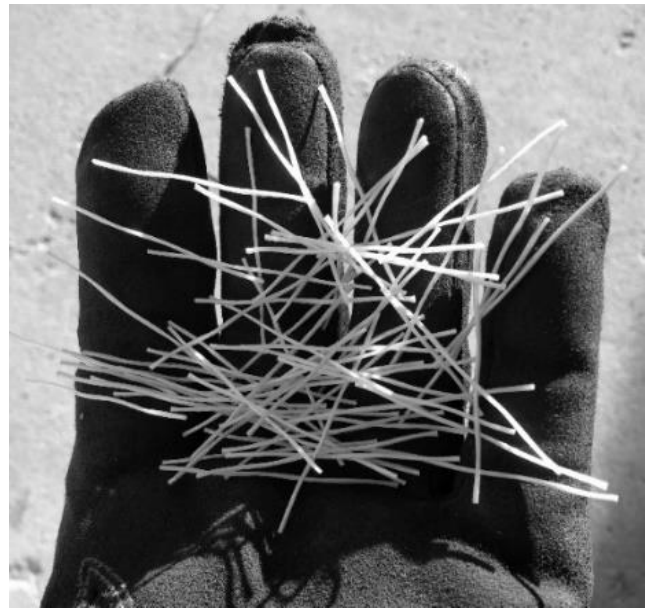
Figure 1. Macrofibers used in this research.2.1. Specimen Design